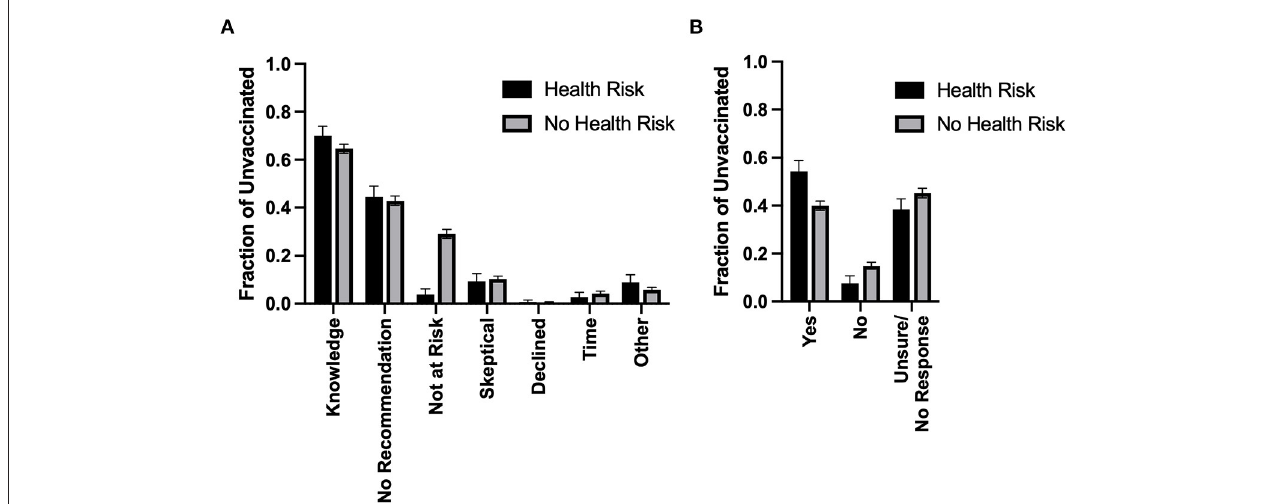
FIGURE 2 | Reasons for not vaccinating and intention to vaccinate among unvaccinated. (A) Reasons for not obtaining pneumococcal vaccination among unvaccinated: The fraction of unvaccinated individuals reporting the indicated reasons for not obtaining pneumococcal vaccination, stratified by individuals reporting one or more health risks, or individuals reporting no health risks ( n = 4,028). (B) Willingness to receive pneumococcal vaccination: The fraction of unvaccinated individuals reporting willingness for obtaining pneumococcal vaccination in the future, stratified by individuals reporting one or more health risks, and individuals reporting no health risks ( n =